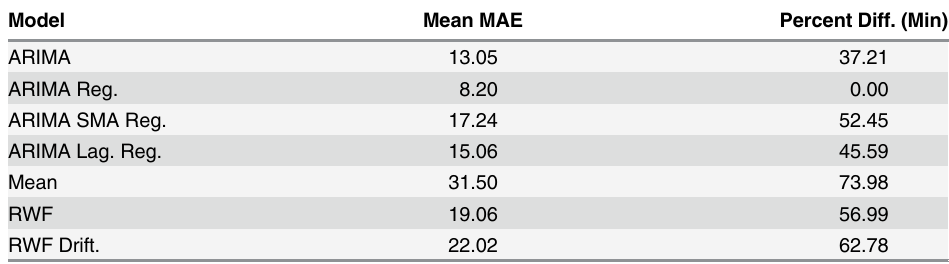
Table 6. Mean of all MAE errors for each node/case